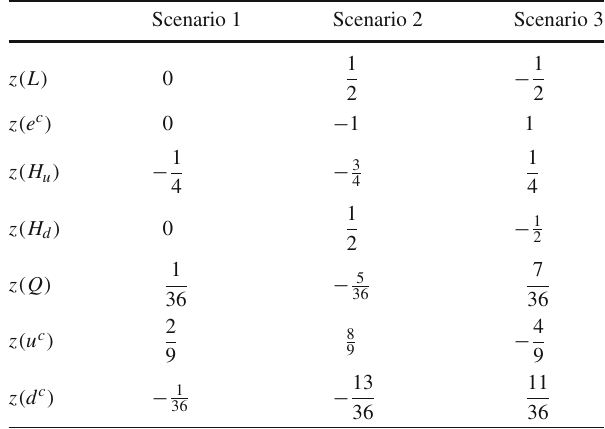
Table 3 Values of the U ( 1 ) (cid:2) charges for the SM matter in U μν SSM models using solution (29) with the exotic quarks ˆ K 1 , 2 , 3 and ˆ K c , − 1 . These values are independent of thesolutions fixing z ( H d ) = 0 , 1 2 2 for z ( F ) , with F denoting the exotic quarks Scenario 1 Scenario 2 Scenario 3